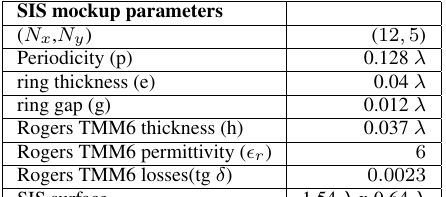
TABLE 1. Main SIS parameters